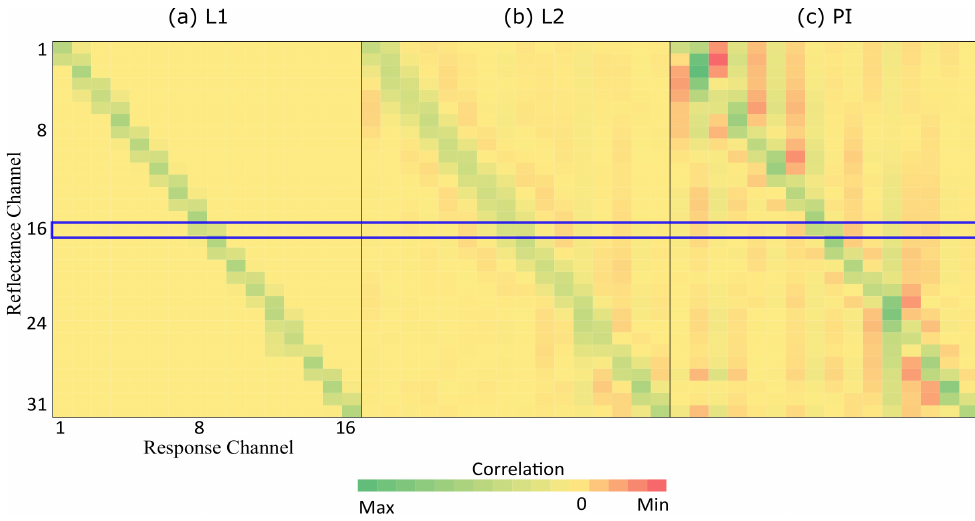
Figure 10. The heatmap representation of weight from different methods.The sub-figures ( a ) show correlation for the proposed L1-norm penalization method, ( b ) shows the L2-norm penalization method, and ( c ) shows the pseudo-inverse method. From the figure, one can see that the correlation is constrained to be zero (yellow color) for most of the entries except the